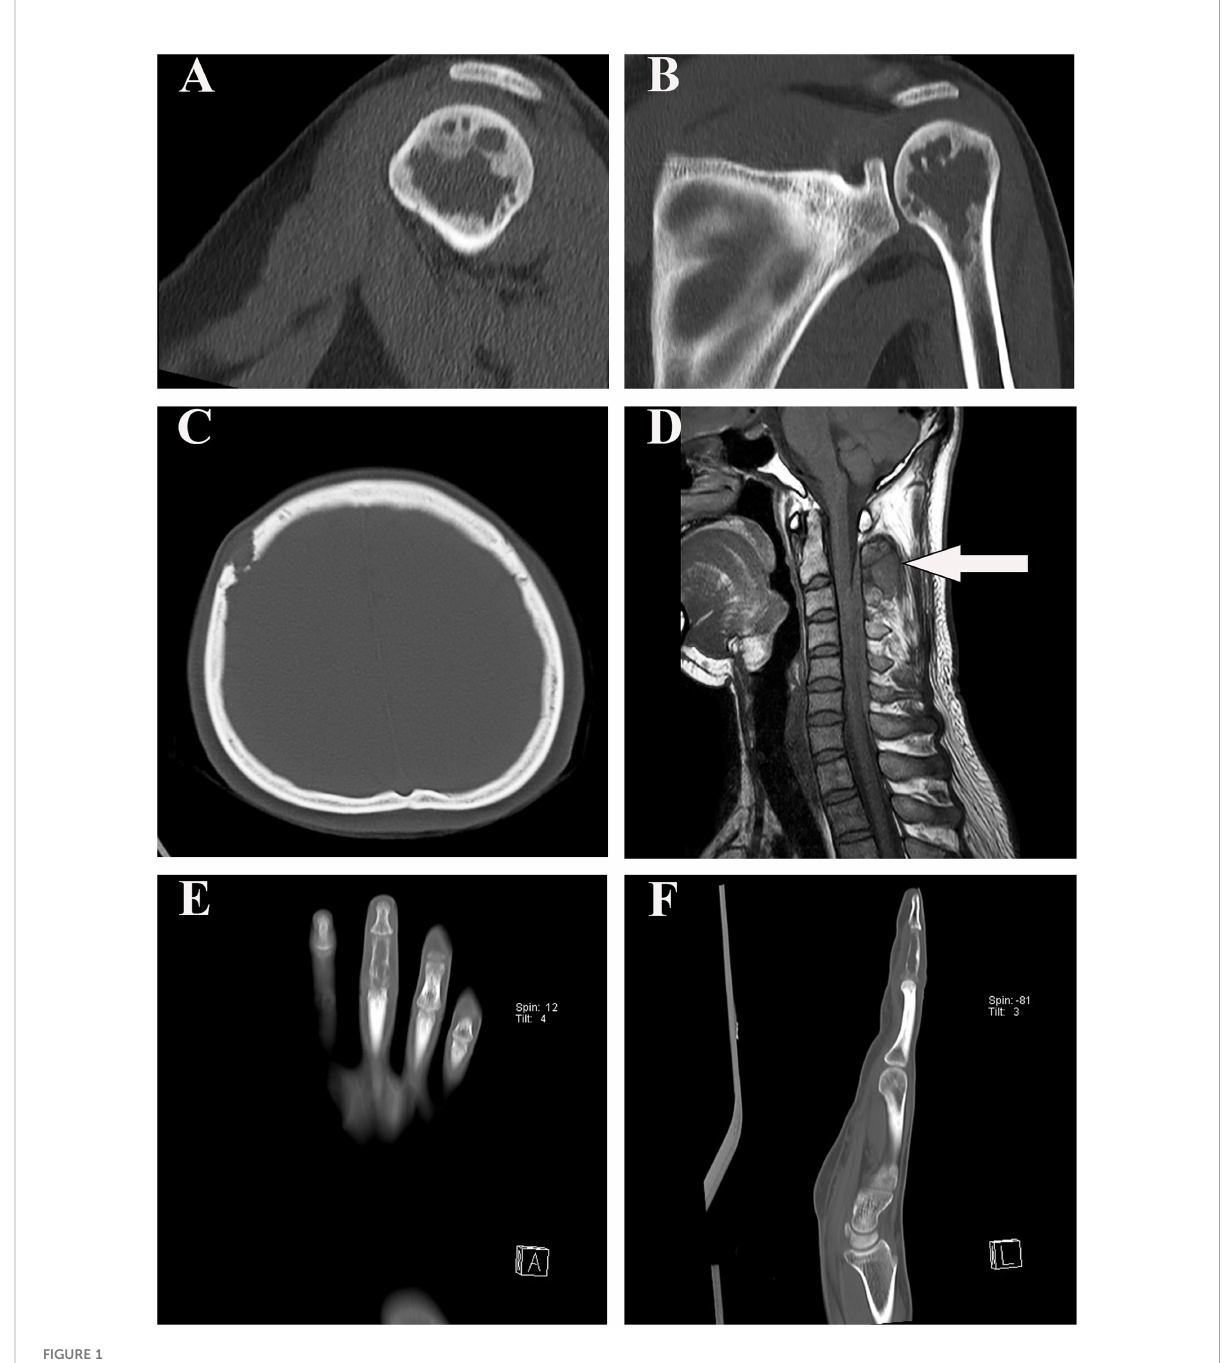
FIGURE 1 Radiographic fi ndings in our four patients. (A, B) The sagittal and coronal computed tomography scan demonstrated that patient #1 had an irregular cystic transparent area in the left proximal humerus metaphysis, extended into the adjacent epiphysis. (C) Computed tomography image showed that the right frontal bone of patient #2 was damaged locally. (D) T1-weighted MRI showed that patient #3 had a hypointense epidural lesion in the spinous process of C2 – C5 (arrow). (E, F) Patient #4 showed an irregular cystic transparent area with trabecular destruction and absorption in the coronal and sagittal computed tomography